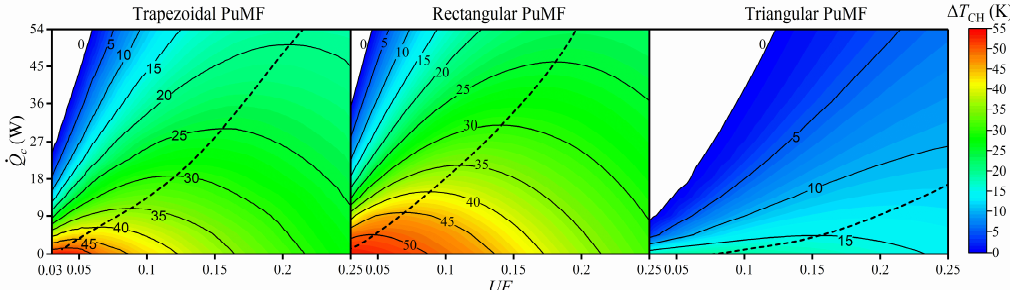
. . Figure 9. Cooling capacity 𝑄 (cid:3030) and temperature difference Δ T CH versus UF under three magnetic Q c and temperature difference ∆ T CH versus UF under three magnetic Figure 9. Cooling capacity field waveforms ( ν = 4.54 Hz, H = 1 T, T h = T i = 293 K, solid line: fixed Δ T CH , dashed line: maximum field waveforms ( ν = 4.54 Hz, H = 1 T, T h = T i = 293 K, solid line: fixed ∆ T CH , dashed line: maximum . . 𝑄 (cid:3030) under the optimal UF ). Q c under the optimal UF ).